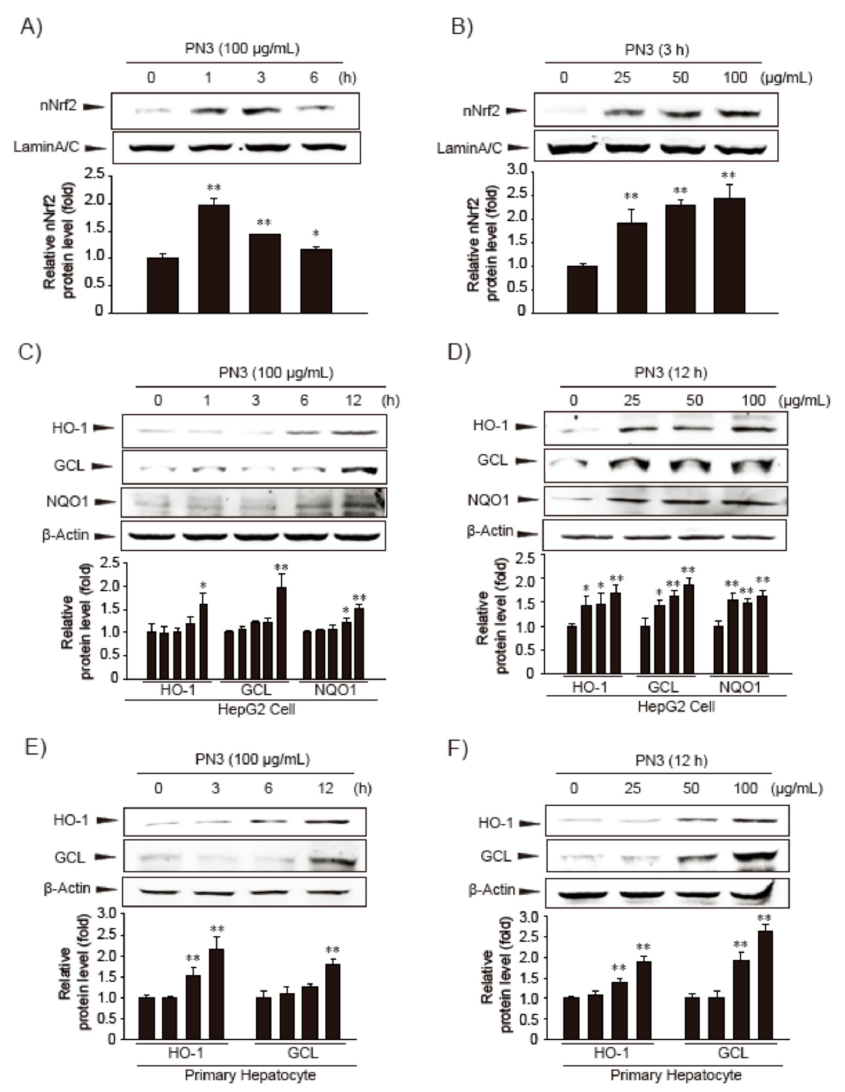
Figure 2. The effect of the ethyl acetate fraction of 80% EtOH extract from the stems of P. nigra var. henosis (PN3) on NF-E2-related factor (Nrf2) activation and Nrf2 target gene expression. ( A ) Time courses of nuclear Nrf2 (nNrf2) translocation in HepG2 cells treated with 100 µg/mL PN3. The Nrf2 protein was immunoblotted from the nuclear fractions of cells that had been incubated with PN3 for 1 to 6 h. ( B ) Varying concentrations of PN3 for 3 h on nuclear Nrf2 translocation in HepG2 cells. Nuclear Nrf2 protein was immunoblotted from cells treated with PN3 (25–100 µg/mL). ( C ) HepG2 cells were treated with 100 µg/mL PN3 for 1 to 12 h. The proteins, HO-1, GCL, and NQO1, were immunoblotted from the lysates of cells. ( D ) The expression of Nrf2 target genes in HepG2 cells treated with indicated concentrations of PN3 for 12 h. ( E , F ) The effect of PN3 on the expression of Nrf2 target genes in mouse primary hepatocytes. Primary hepatocytes were incubated for varying times (3–12 h) and at different concentrations (25–100 µg/mL) of PN3. Data represent the mean ± S.D. of 3 replicates; * p < 0.05, ** p < 0.01, significant versus vehicle-treated control. 3.2. Nrf2 Phosphorylation by ERK, P38 MAPKs, and PKC δ in PN3 Phosphorylation of Nrf2 by various protein kinases leads to its release from Keap1, which allows it to translocate into the nucleus, where it exerts gene transcription [17]. Treatment with PN3